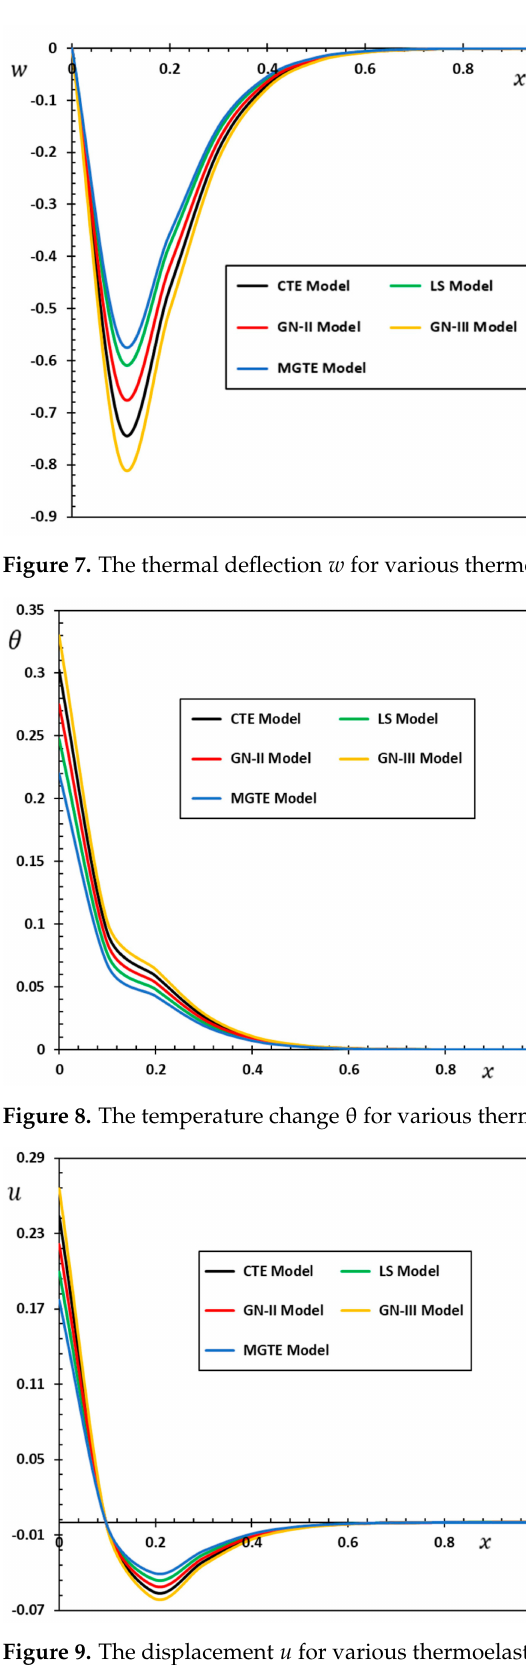
Figure 9. The displacement u for various thermoelastic